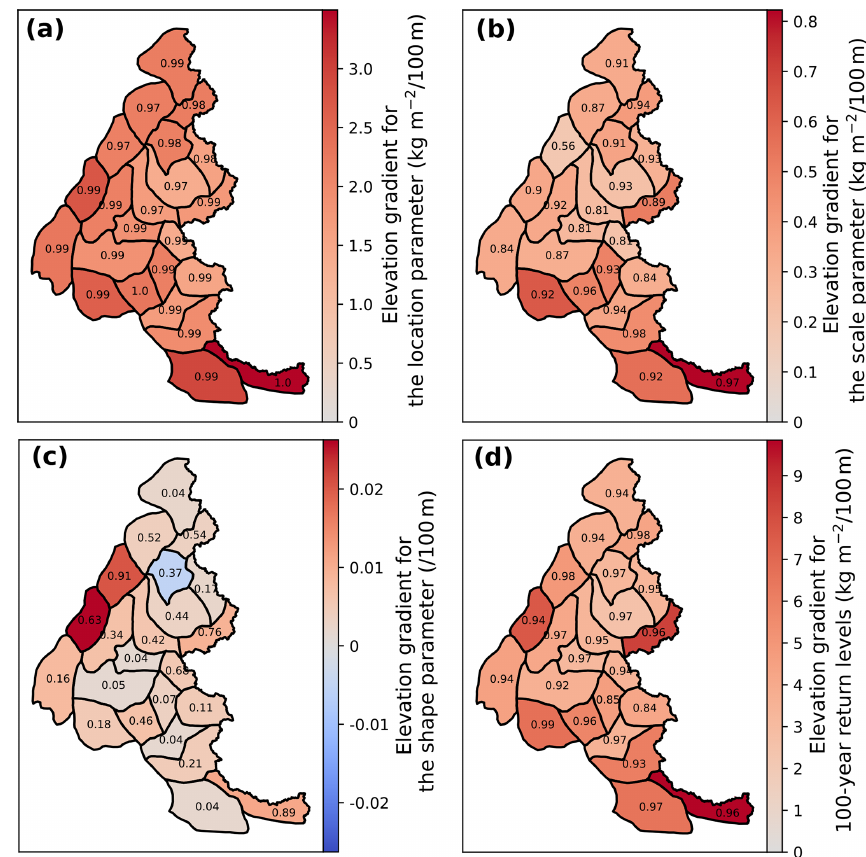
Figure 3. Elevation gradients for the GEV parameters (a–c) and 100-year return levels (d) for the 23 massifs of the French Alps. GEV distributions are estimated pointwise for the annual maxima of daily snowfall every 300m of elevation. Elevation gradients are estimated with a linear regression. The R 2 coefficient is written in black for each